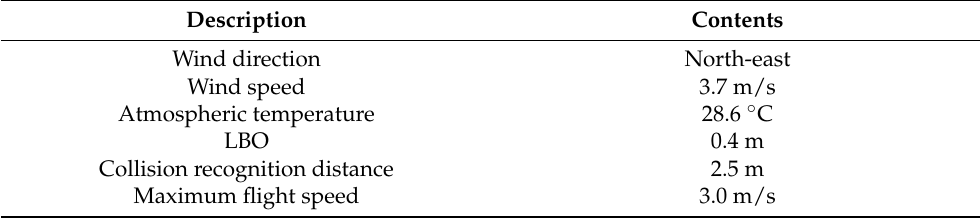
Table 3. Field experiment conditions and